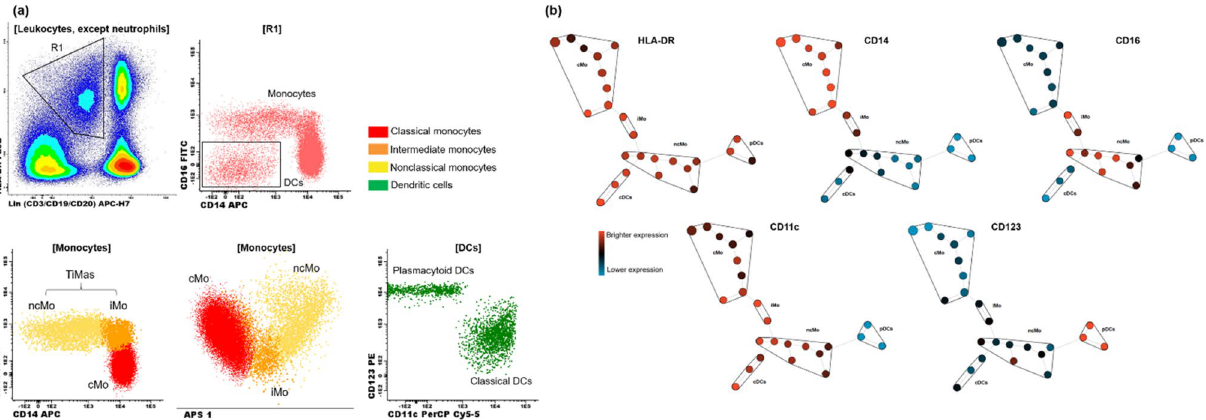
Figure 6. Panel ( a ) Gating strategy of circulating monocyte and dendritic cell (DC) subsets by multiparameter flow cytometry. Cells that were negative for CD3, CD19 and CD20 (lineage negative) and HLA-DR + were gated (R1). CD14 and CD16 negative cells (DCs) were then separated from monocytes. Classification of classical (CD14 + CD16 neg ), intermediate (CD14 + CD16 + ) and nonclassical monocytes (CD14 lo CD16 + ). DCs were classified according to CD11c and CD123 expression in classical (cDC) (CD11c + CD123 lo ) and plasmacytoid DCs (pDC) (CD123 ++ CD11c neg ). Panel ( b ) Monocyte and DC clusters identified by SPADE.